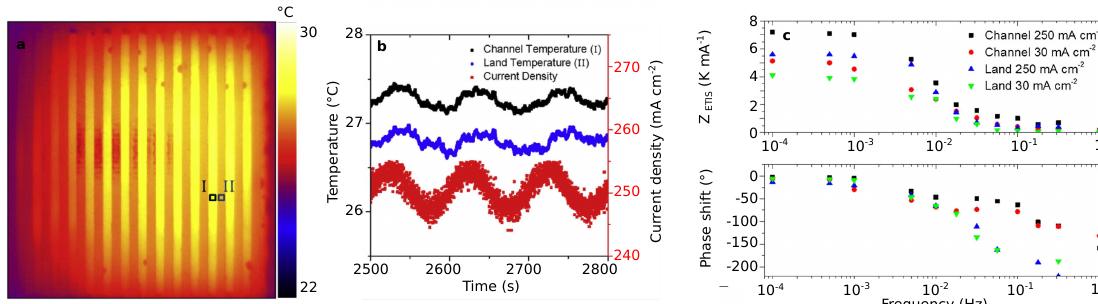
Figure 5. Electro-thermal impedance spectroscopy (ETIS) technique: ( a ) Thermal infrared image of the open cathode depicting area of the channel (I) and at the land (II), ( b ) measured current density input and temperature output at the channel (I) and at the land (II) in time domain, and ( c ) magnitude and phase Bode plots of Z ETIS measured at the channel and at the land at different polarisation currents. Figures taken from reference [13], with permission from